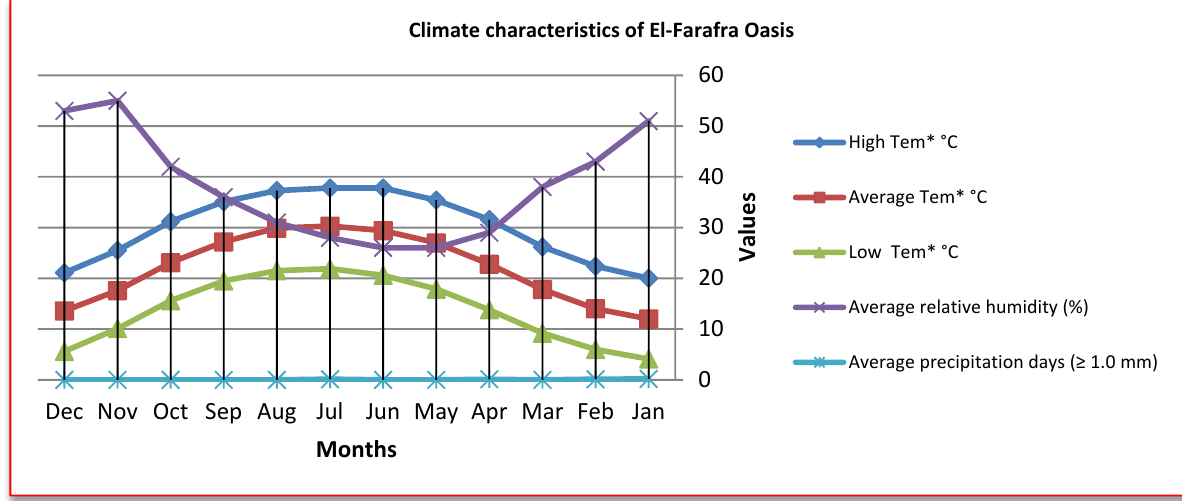
Figure 2. Climate characteristics of El-Farafra Oasis.